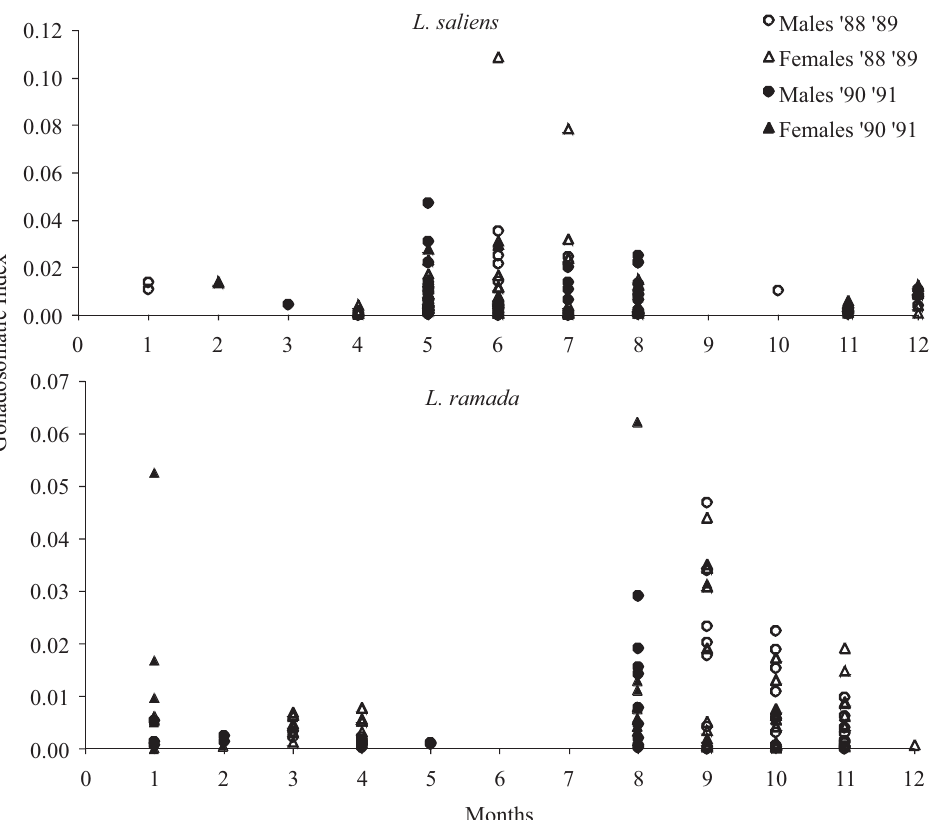
Fig. 4. Variation in the gonadosomatic index (GSI) values of each single male and female of Liza saliens and Liza ramada caught during the sampling period